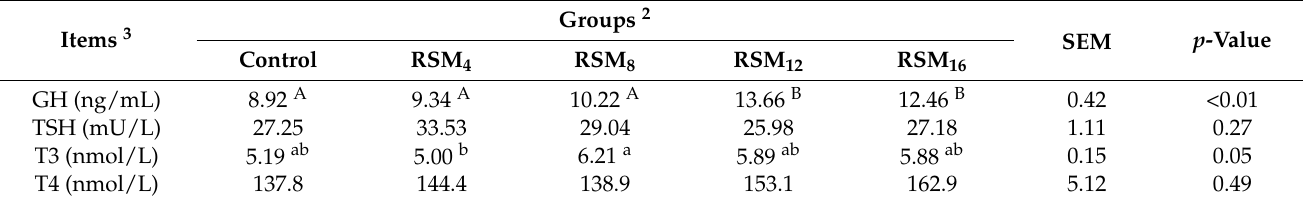
Table 7. Effects of increasing dietary levels of rapeseed meal on serum hormonal parameters of geese at 70 d of age 1 . Items 3